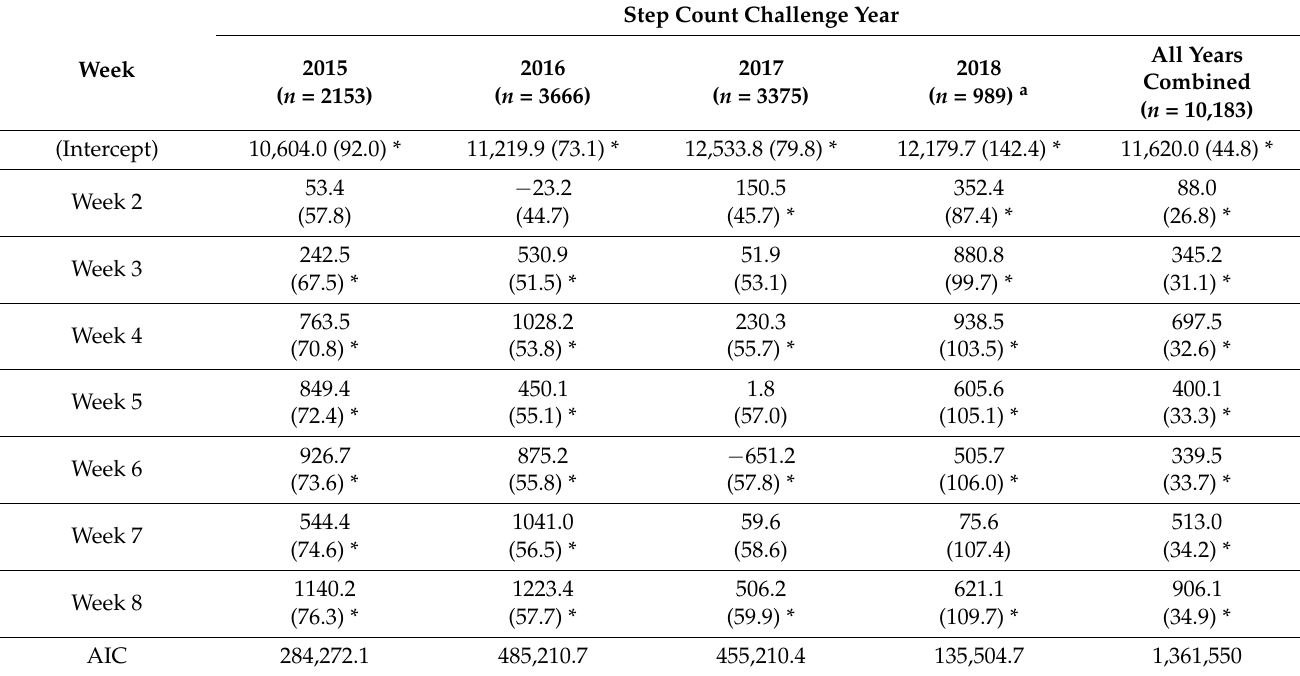
Table 2. Model 1: Change in mean (standard error) daily step count over time relative to week 1.